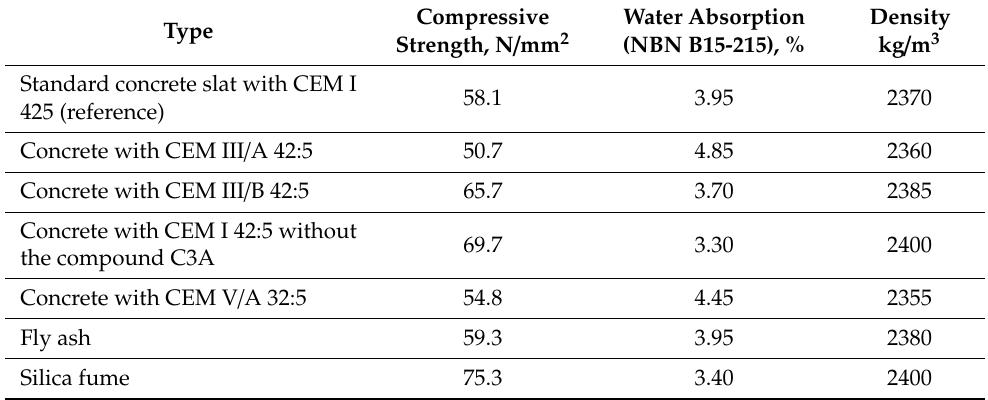
Table 4. Variations in compressive strength, water absorption and density in di ff erent concretes [12]. “Reproduced with permission from De Belie, J. Agric. Eng. Res. published by Elsevier,